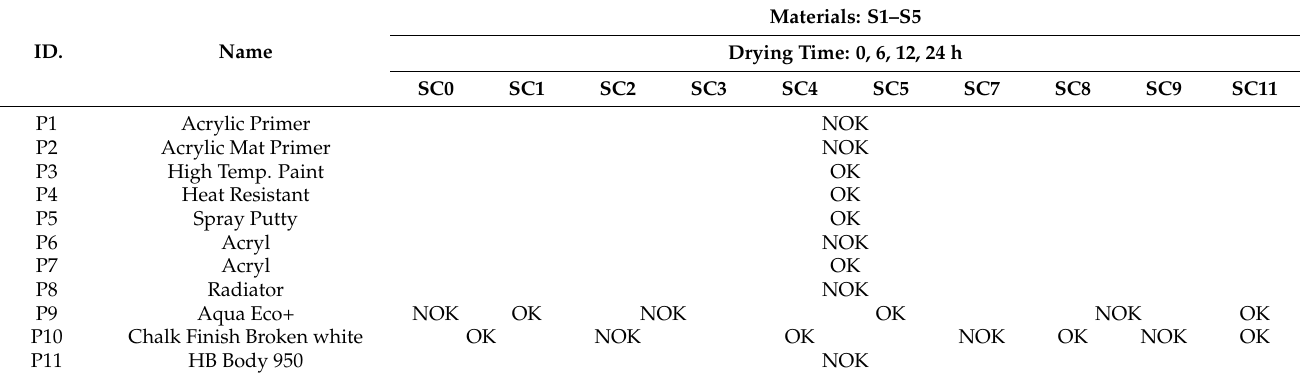
Table 8. Results of the cross-cut